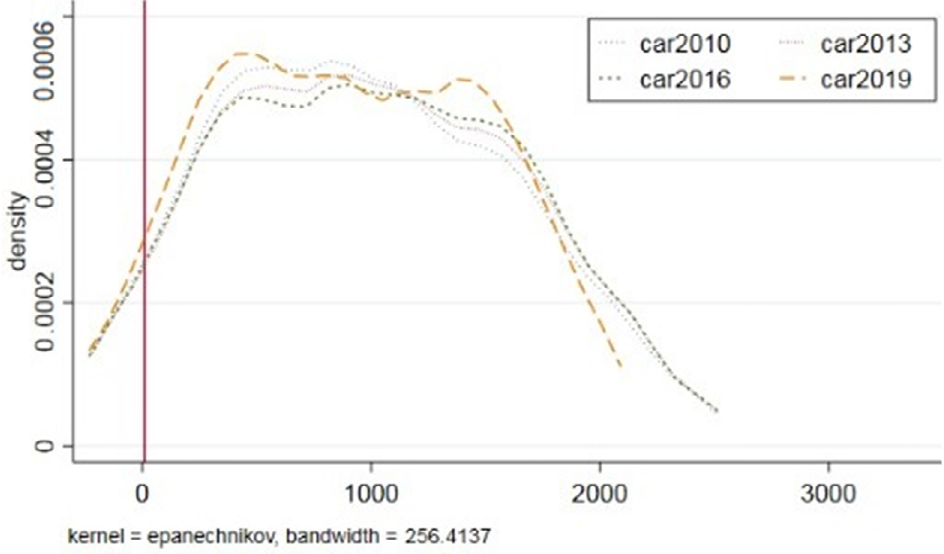
Figure 3. Distribution of Kernel density estimates of agricultural carbon emissions for selected years in